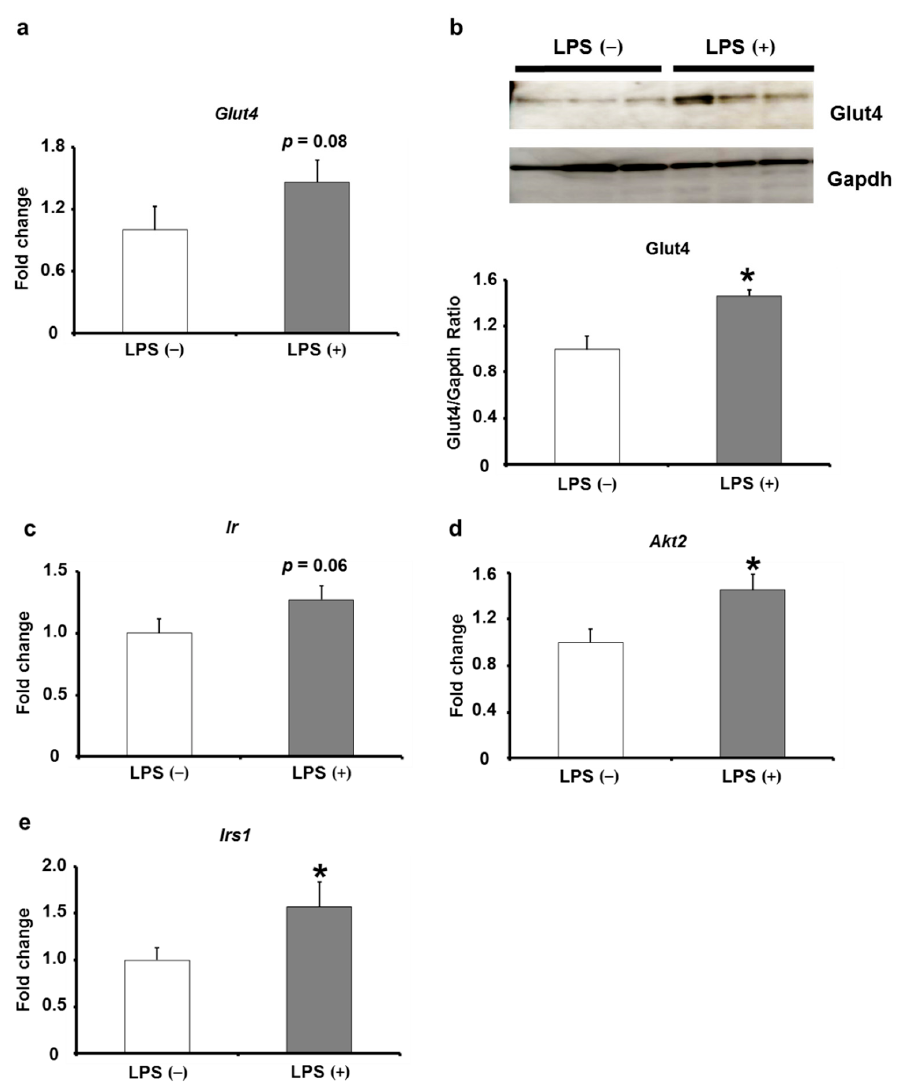
Figure 5. Effects of orally administered LPS on insulin signaling-related molecule expression in adipose tissues of KK/Ay mice. ( a ) The relative mRNA expression of Glut4 was measured ( n = 8). ( b ) The relative protein level of Glut4 was measured by Western blot analysis ( n = 8). ( c – e ) The relative mRNA expression levels of Ir , Akt2, and Irs1 were measured by quantitative reverse-transcription polymerase chain reaction ( n = 8). Values are presented as the mean ± SE. * p < 0.05 vs. LPS ( − )